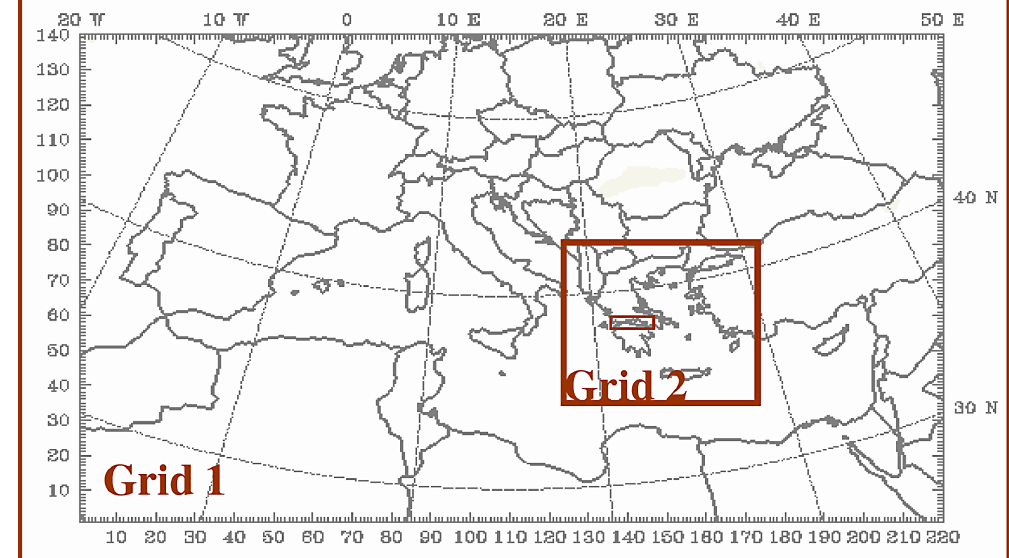
Fig. 2. Horizontal extensions of MM5 operational grids. The rectangles inside the grid 1 area (24km grid spacing) denote the location of grid 2 (8km grid spacing) as well as the studied area of Corinthian Gulf, which is found inside the intermediate grid.